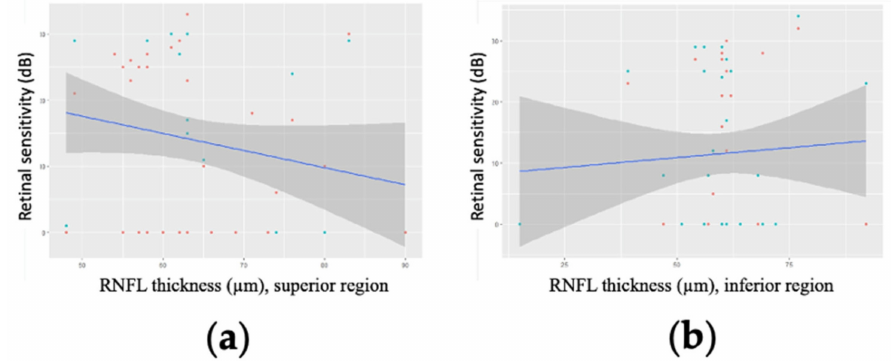
Figure 3. Linear regression modelling of retinal sensitivity as a function of mean retinal nerve fibre layer (RNFL) thickness for 27 patients (29 eyes) with advanced glaucoma for two points in ( a ) the superior part of the visual field ( p = 0.12) and ( b ) the inferior part of the visual field ( p = 0.62).